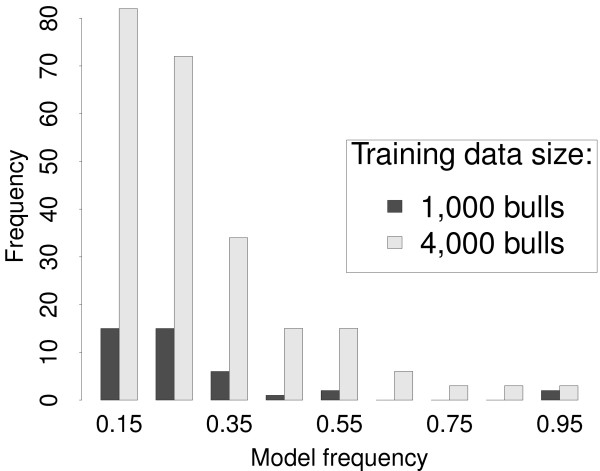
Histogram of model frequencies > 0.1 obtained by BayesB with π = 0.99 using 1,000 and 4,000 training bulls.